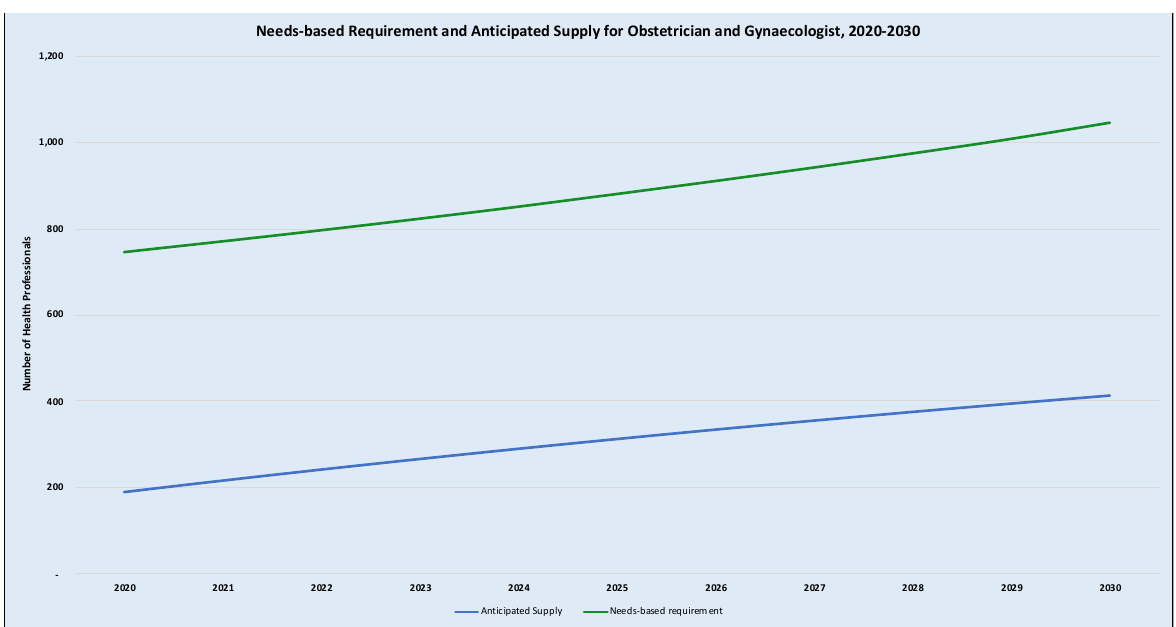
Figure 2. Needs-based requirements and anticipated supply of midwives. Notes: Figure 2 illustrates the projected trend of the need-based requirement for midwives (the green line) as compared to the anticipated trend of supply in the blue line.